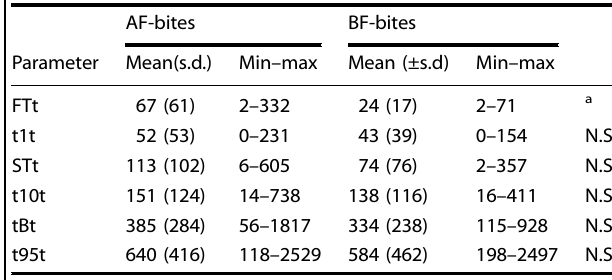
Table 3. The timing